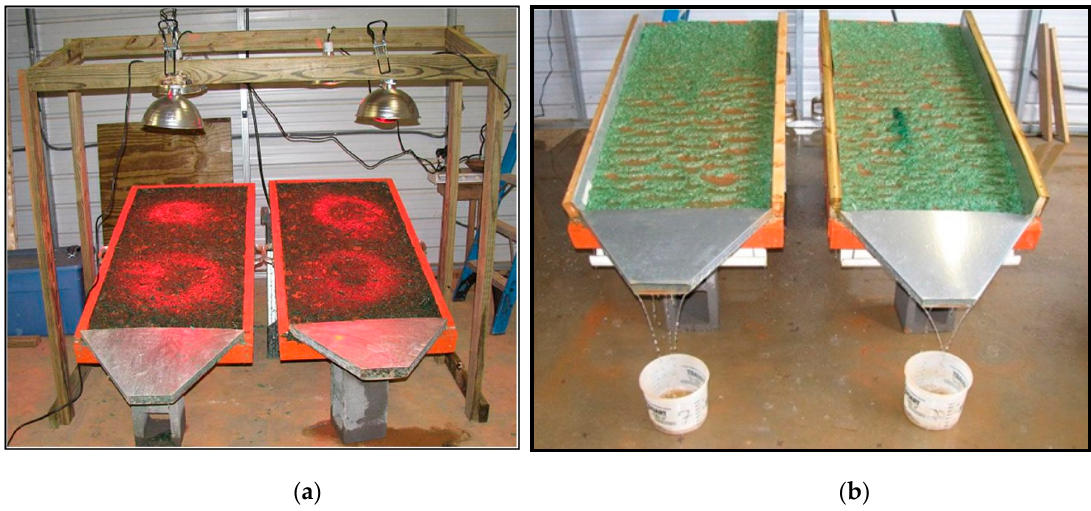
Figure 4. ( a ) Drying of test plots during hydromulch testing; ( b ) collection from runoff for each test plot.